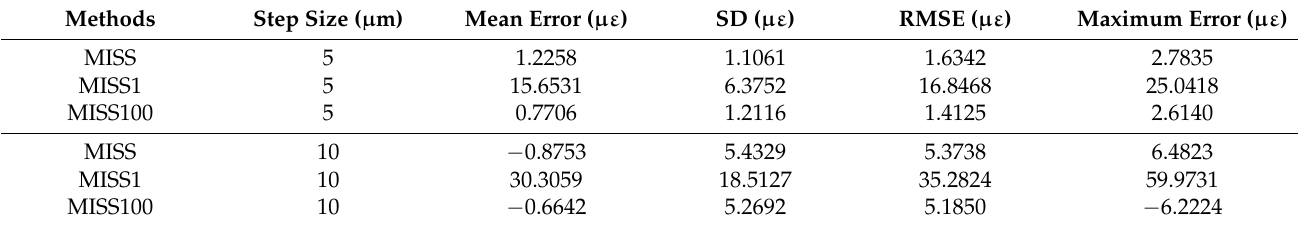
Table 2. Errors analysis for the dynamic tests.